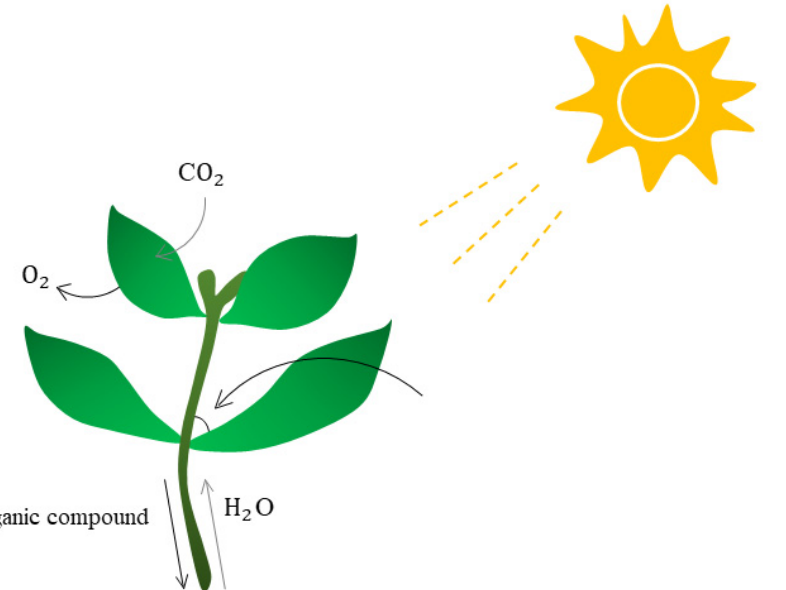
Figure 2. The effect of plant leaf angle. The angle of plant leaves has a strong influence on many plant activities. When the plant leaf angle is optimal, plants enjoy a high photosynthetic rate, thus producing more organic matter. Creating new species with optimal leaf angles could help plants synthesize more organic matter, leading to better growth and, in turn, increased survival and yield.